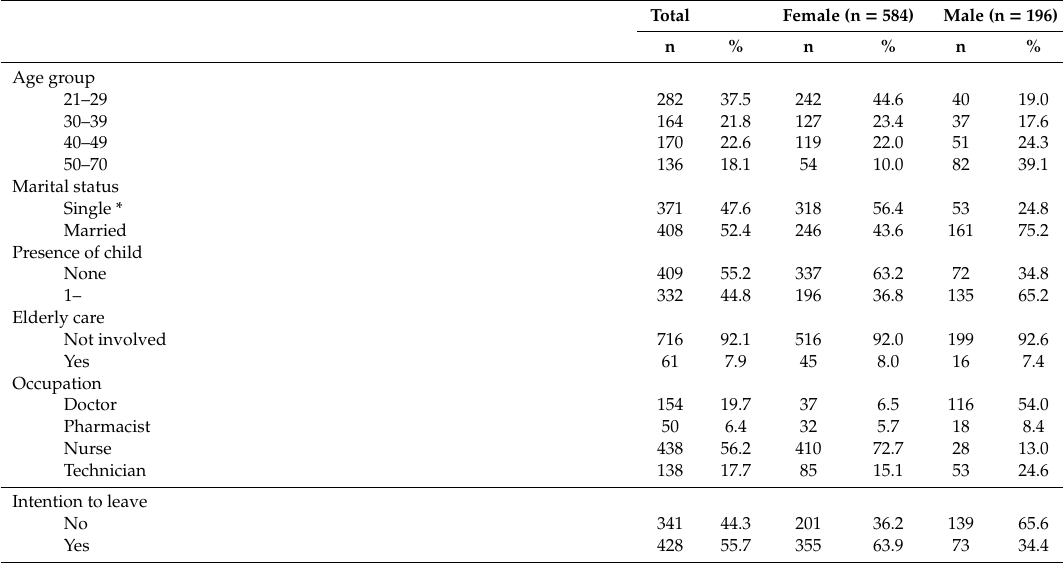
Table 1. Characteristics of our